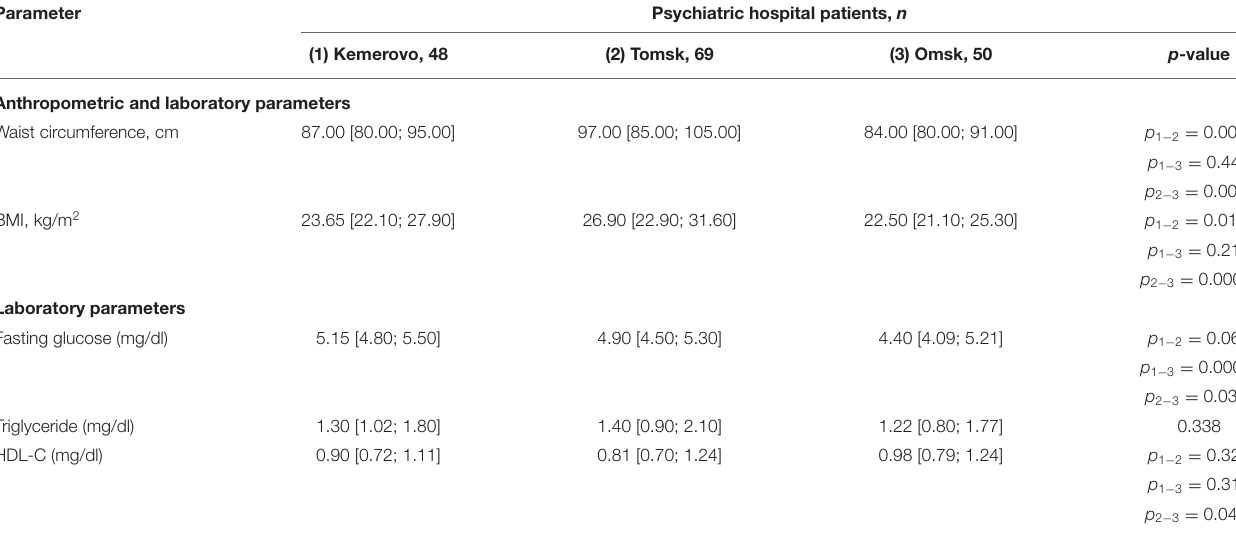
TABLE 8 | Comparative characteristics and evaluation of anthropometric and laboratory parameters in the male part of the study population (Me [Q1; Q3]). Parameter